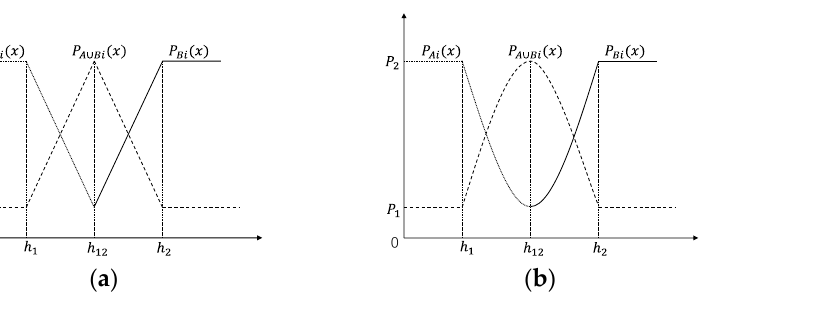
Figure 4. Three typical BPA functions: ( a ) triangular; ( b ) ridge-shaped; ( c ) pointed.